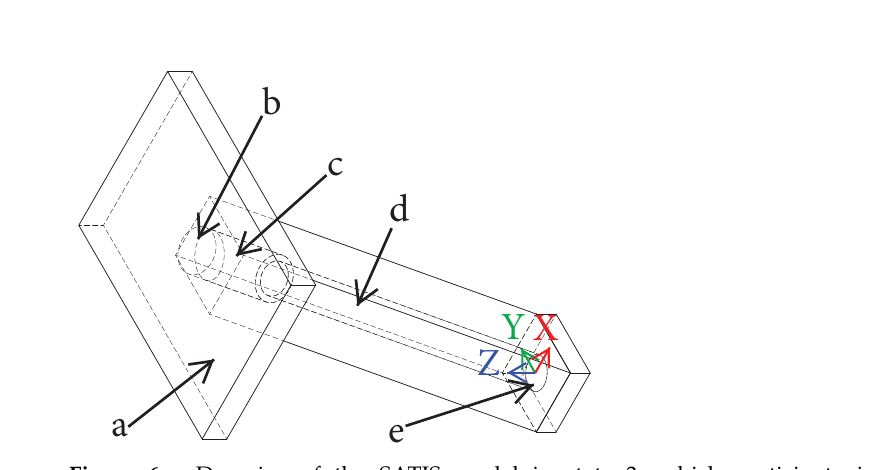
Figure 6. Domains of the SATIS model in state 3, which participate in the short-wave radiation transport. Table 4. Applied boundary conditions for computing the short-wave radiation